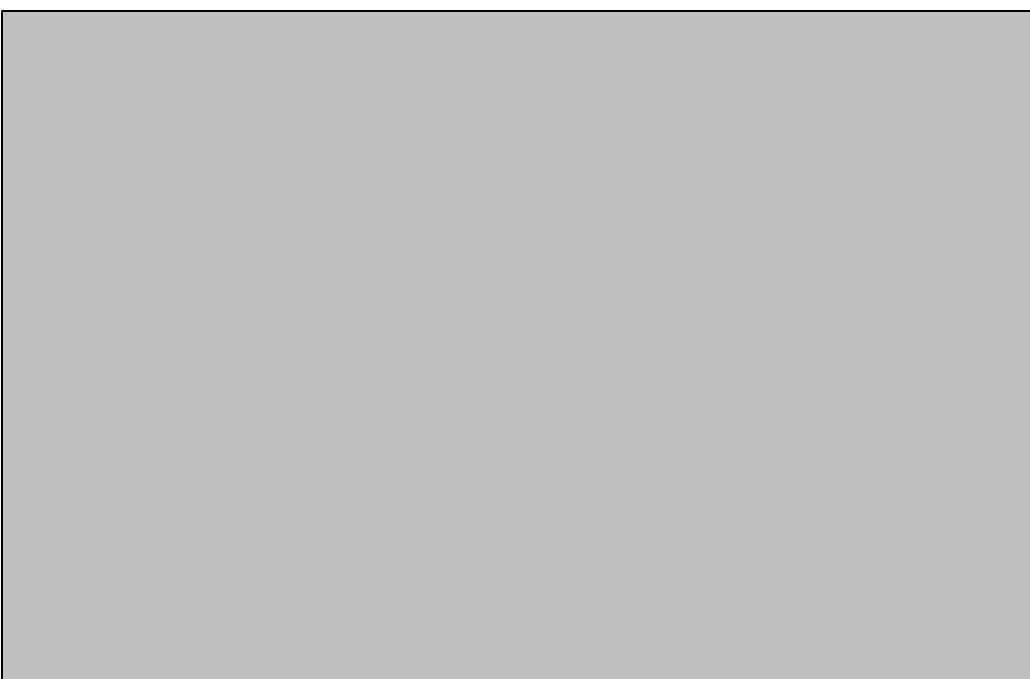
Table III : Most commonly prescribed drug